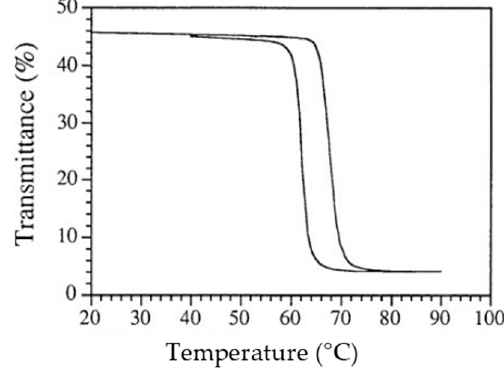
Figure 14. An example of hysteresis curve observed for a thermochromic VO 2 film [160]. Buildings 2016 , 6 , 37